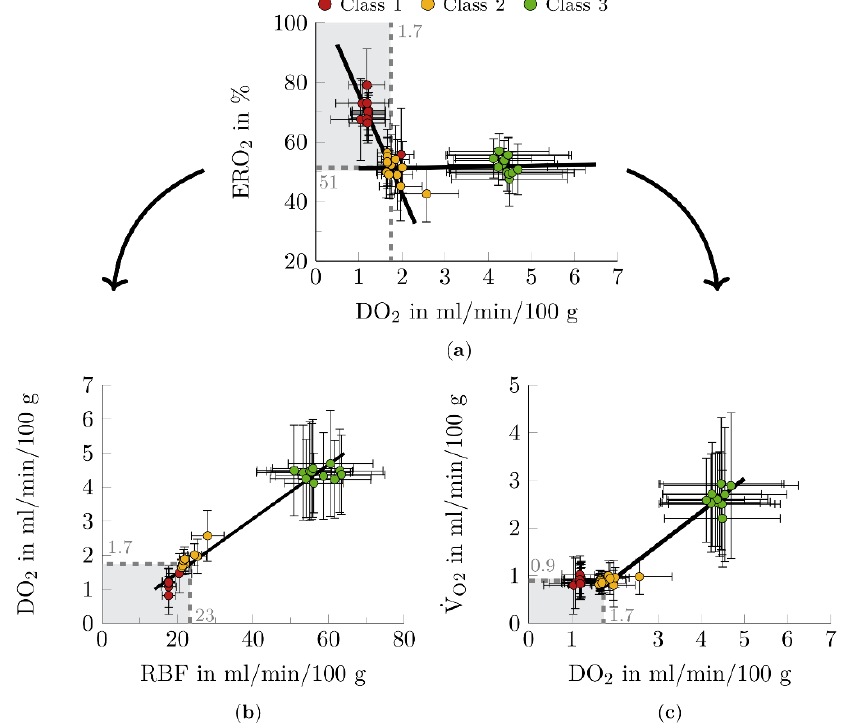
Figure 2. Function markers for metabolic activity. ( a ) Dependence oxygen extraction (ERO 2 ) on oxygen delivery (DO 2 ). At a critical point (DO 2, crit = 1.7 mL/min/100 g, ERO 2, crit = 51%) corresponding to the intersection of the two lines (f(x) 1 = − 33.337x + 109.43, f(x) 2 = 0.2292x + 50.933; shown as black lines), ERO 2 increased considerably. ( b ) Dependence DO 2 on renal blood flow (RBF). The data suggest a linear relationship between the RBF and DO 2 (R 2 = 0.97, y = 12.57x + 1.3984; shown as black line). RBF crit was determined by substituting DO 2, crit into the linear equation. ( c ) Dependence of oxygen consumption ( V̇ O 2 ) on DO 2 . When the critical point (DO 2, crit = 1.7 mL/min/100 g, V̇ O 2, crit = 0.9 mL/min/100 g) was exceeded, the amount of oxygen consumed by the tissue increased. Considering the linear behavior shown in ( a ), the relationship between DO 2 and V̇ O 2 could be described as quadratic below the critical point (y = − 0.696 × 2 + 1.7915x − 0.3326, shown as black curve), and linear beyond (R 2 = 0.94, y = 0.696x − 0.4451, shown as black line). The gray areas illustrate the critical areas of the function markers. Data points represent the twelve times of measurement during the NMP. Plot mean ± SEM. n = 3 for nonfunctional kidneys (class 1), n = 5 – 7 for limited functional kidneys (class 2), n = 9 – 11 for functional kidneys (class 3). n < actual number of kidneys per class (see Section 2.3), because unfortunately blood gas analysis could not always be performed for all kidneys at all time points.